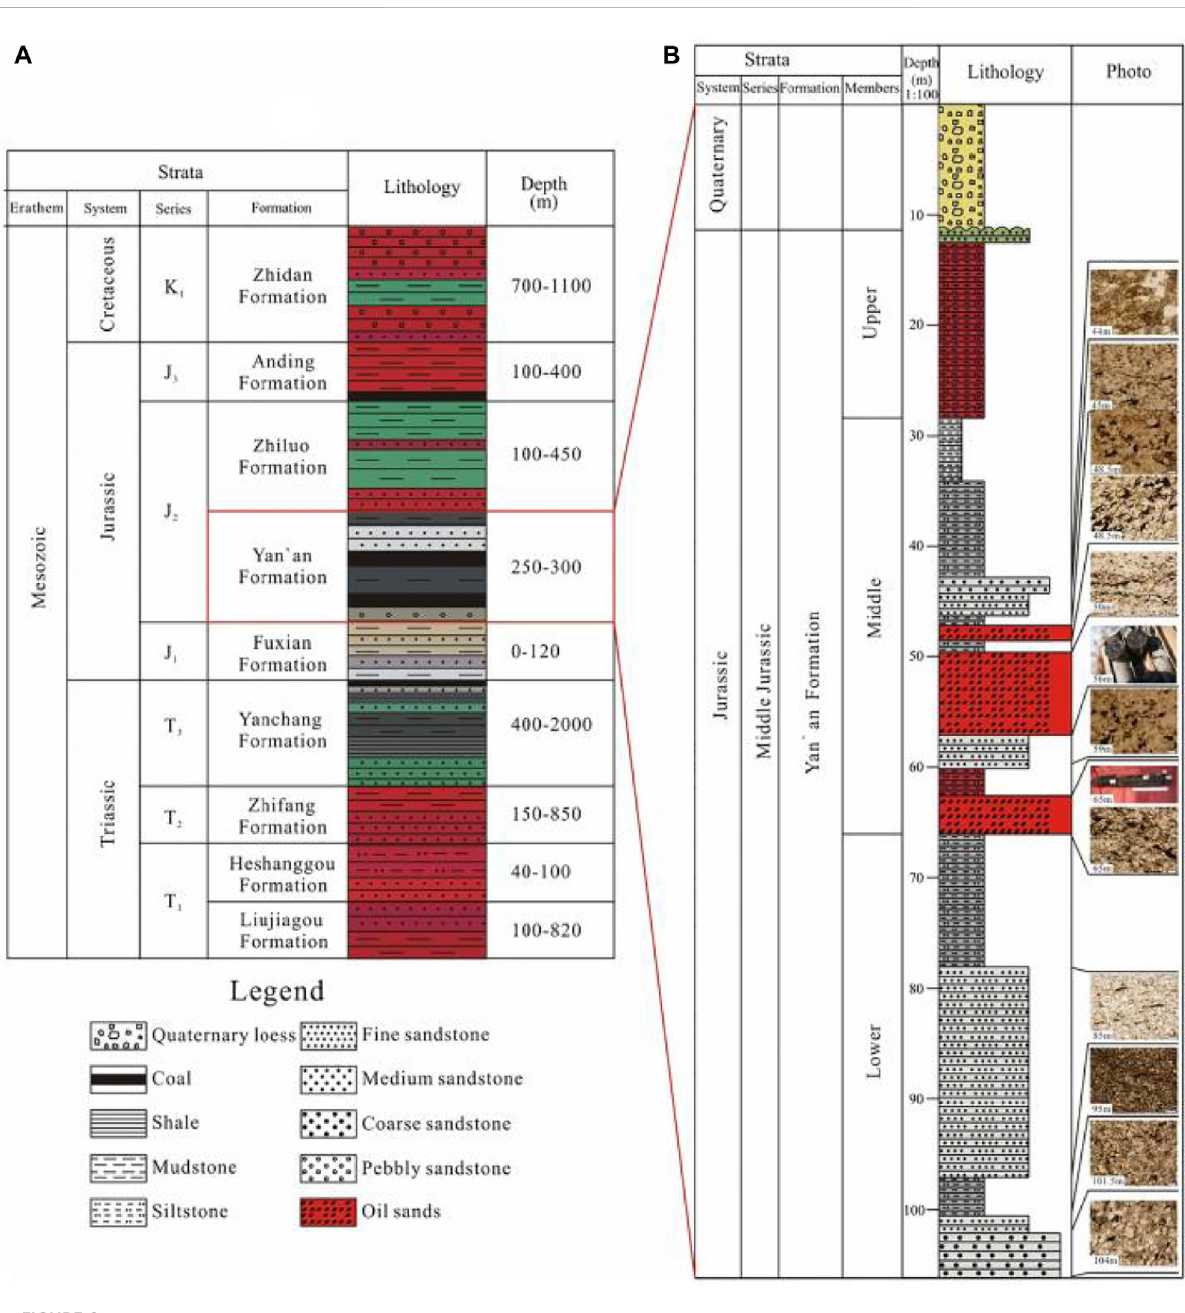
Frontiers in Earth